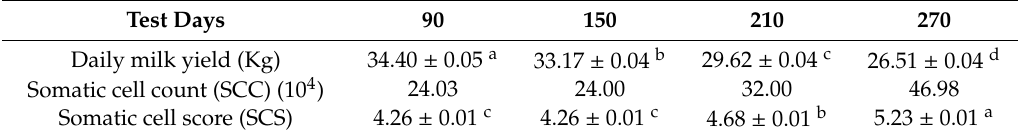
Table 2. Milk yield, somatic cell count, somatic cell score in di ff erent test days (means ± SE).